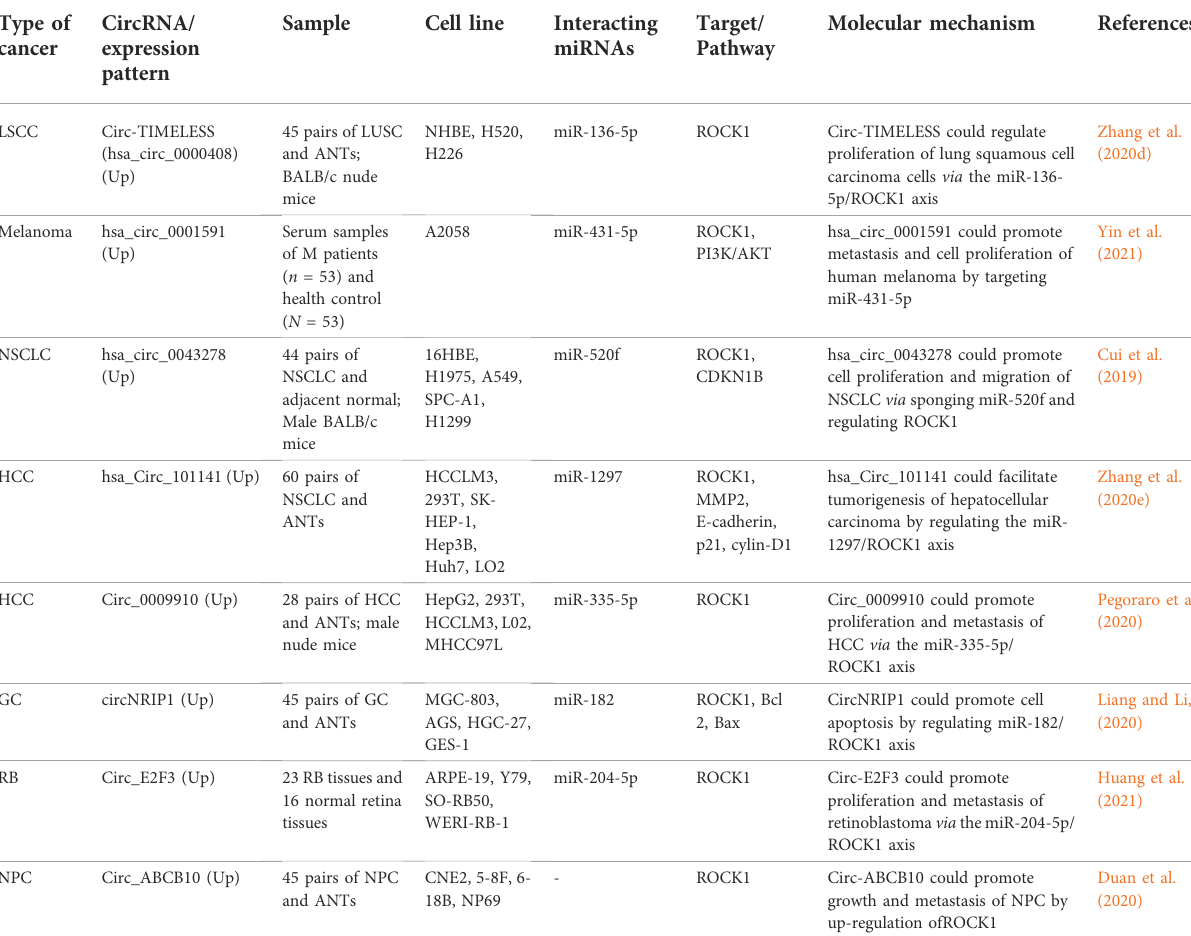
TABLE 4ROCK1-interacting circRNAs in cancers (ANT: adjacentnon-cancerous tissue, LSCC: Lungsquamouscellcarcinoma, NSCLC: Non-small cell lung cancer, HCC: Hepatocellular carcinoma, GC: gastric cancer, RB: retinoblastoma, NPC: Nasopharyngeal carcinoma). Type of